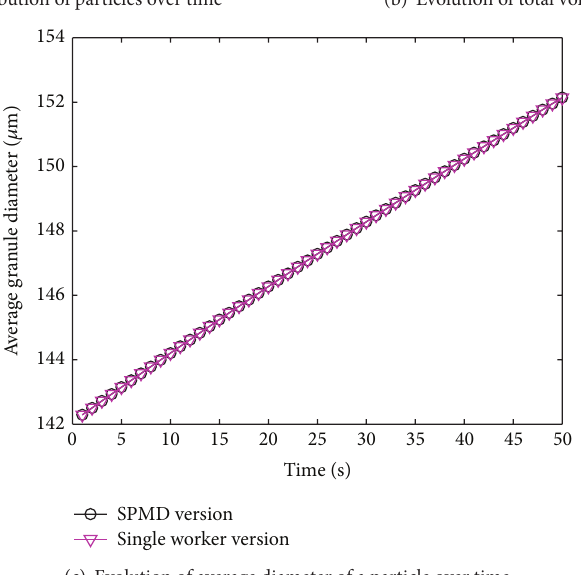
Figure 5: Comparison of temporal evolution of granule physical properties for a sequential and parallel PBM code, grid size = 15.